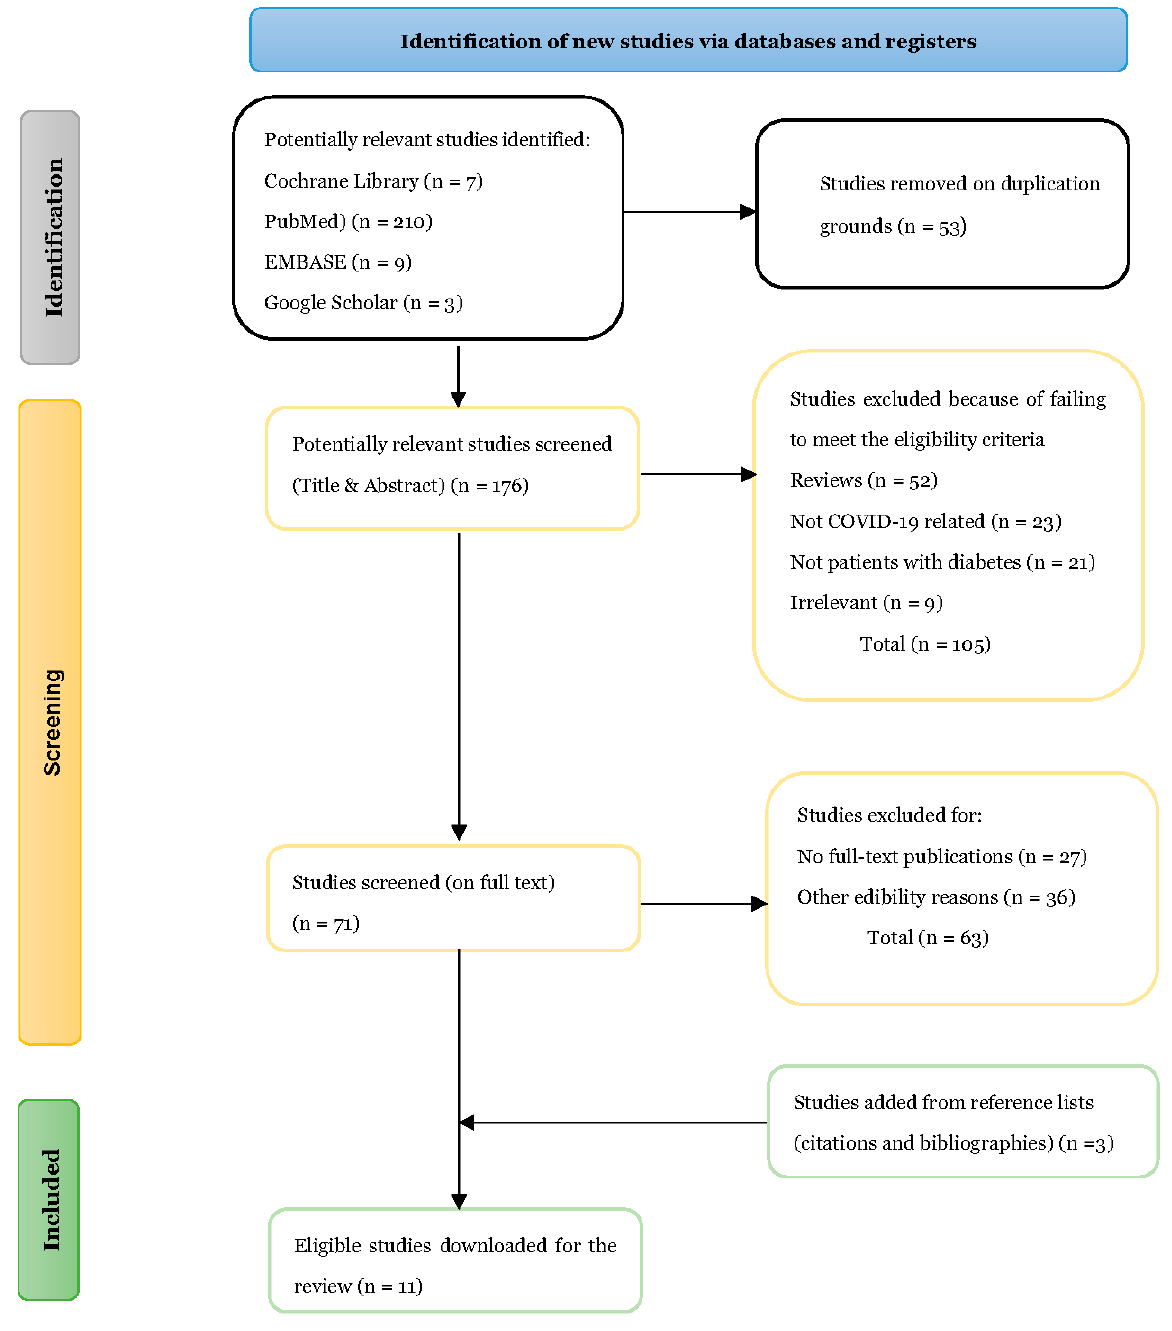
Figure 1. PRISMA flow diagram of the search strategy, selection process, and included studies.